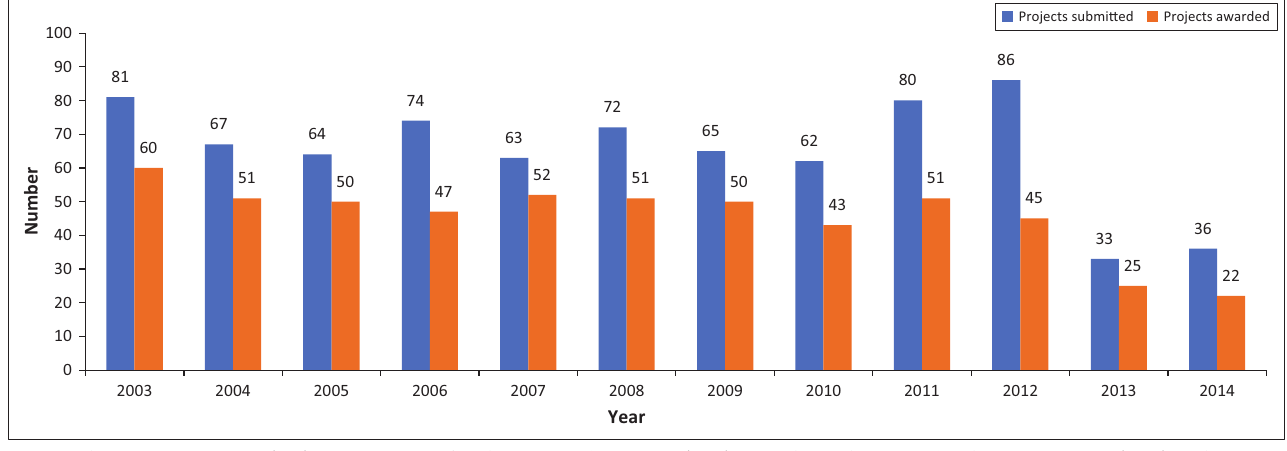
FIGURE 3 : Kaohsiung City Government Research and Development Results Statistics